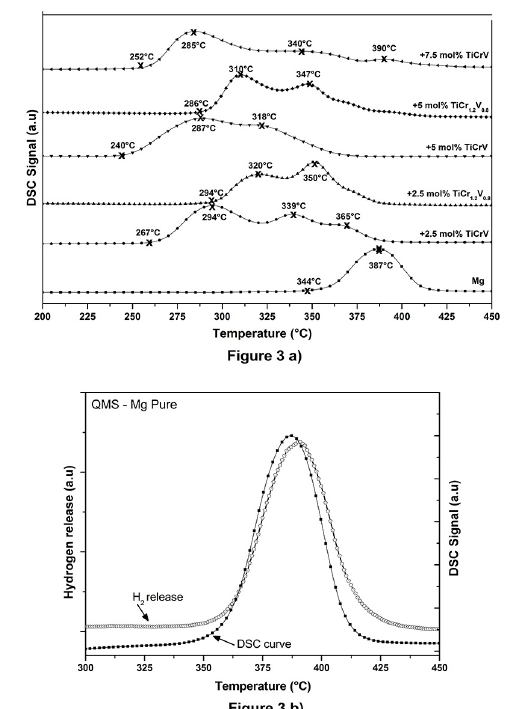
Figure 3. (a) DSC curves for Mg pure and for Mg containing 2.5, 5 and 7.5 mol % of TiCrV and 2.5 and 5 mol% of TiCr RM. The values for the onset and peak temperatures are included in the top of each curve. (b) QMS analysis for Mg pure sample after reactive milling indicating only the hydrogen release from the DSC